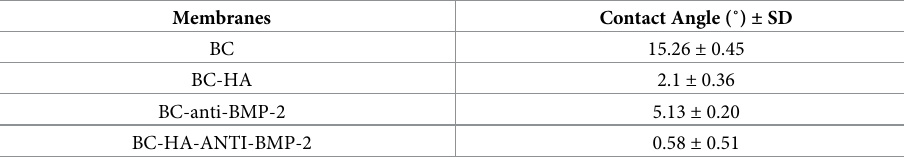
Table 3. Measured contact angle values for BC and BC-HA samples.